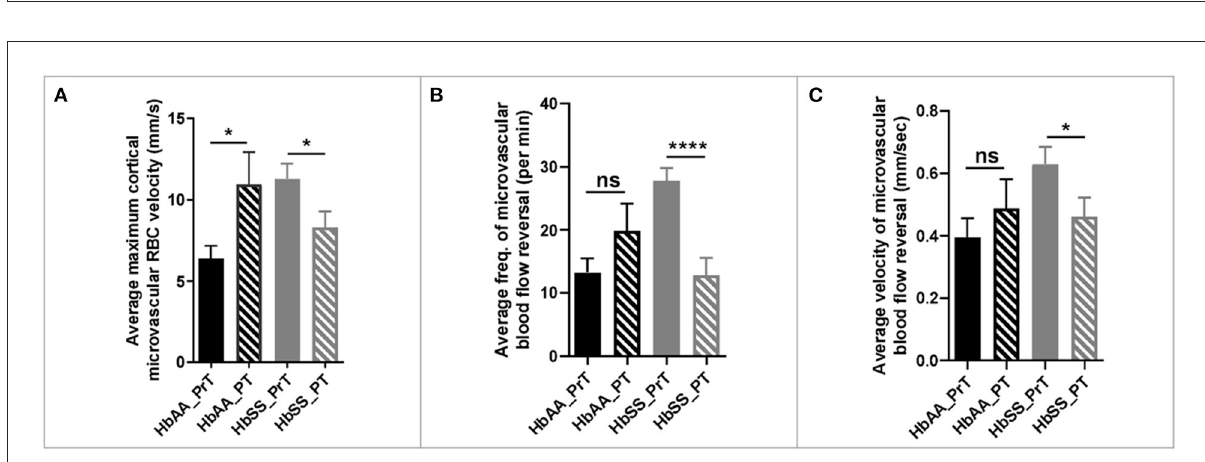
FIGURE5 Hemodynamic analysis in sickle cell and control mice before and after blood or saline transfusion. (A) average maximum capillary RBC velocity in millimeters per second. (B) average frequency of capillary blood flow reversal per minute (C) average velocity of capillary blood flow reversal in millimeters per second (AA: n = 3–5; SS: n = 5–7). Error bars are standard error of means (SEM). NS, Not significant; * p ≤ 0.05; **** p ≤ 0.0001. Mean comparisons done using Welch’s corrected t -test (HbAA_PrT was compared to HbAA_PT and HbSS_PrT was compared to HbSS_PT. There was no cross-genotype comparison since AA mice were not transfused with packed RBC. Prt, Pre-transfusion; PT, Post-transfusion. AA = average of ∼ 73 vessel segments pre-transfusion and 23 vessel segments post-transfusion; SS = average of ∼ 90 vessel segments pre-transfusion and 54 vessel segments